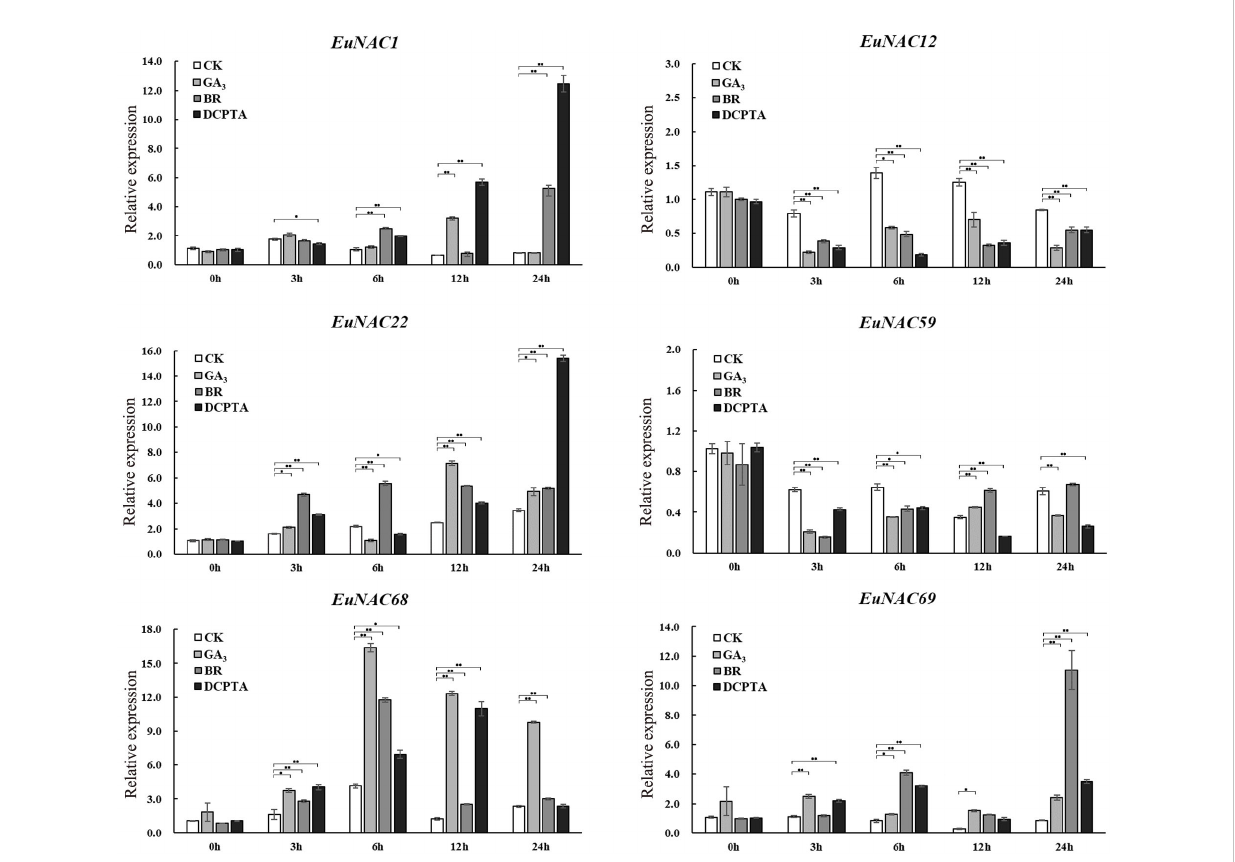
FIGURE 10 The expression patterns of E. ulmoides NAC genes under control condition and hormone treatments were examined by qRT-PCR. Five-month-old seedling leaves of E. ulmoides were sprayed with 300 mg/L gibberellin (GA3), 5 mg/L 1% brassinolide (BR), and 500 mg/L 2-(3,4-dichlorophenoxy)- triethylamine (DCPTA) until there is liquid dripping. Spray water was used as the control treatment. Error bars were obtained from three measurements. The signi fi cance analysis was carried out using Student ’ s t-test (* p < 0.05, ** p <